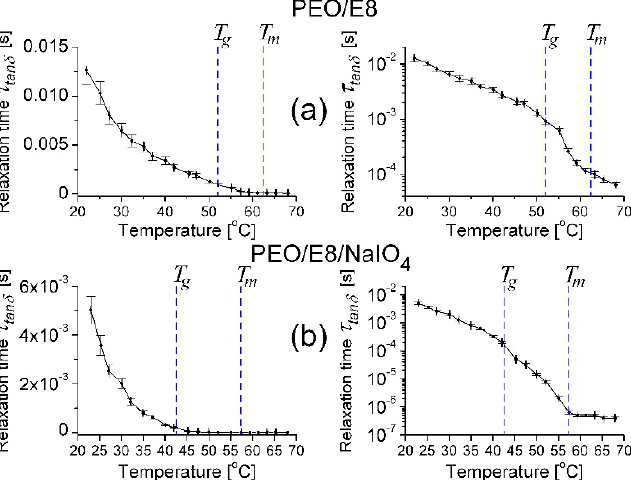
Figure 14. Temperature dependencies of the relaxation times corresponding to the frequency f P ( tan δ ) for PEO/E8 ( a ) and PEO/E8/NaIO 4 ( b ) composites, in linear ( left ) and logarithmic ( right ) scale. The dashed lines point out the values of glass transition temperatures ( T g ) for both composite systems. The error bars represent the uncertainty for the calculated values.